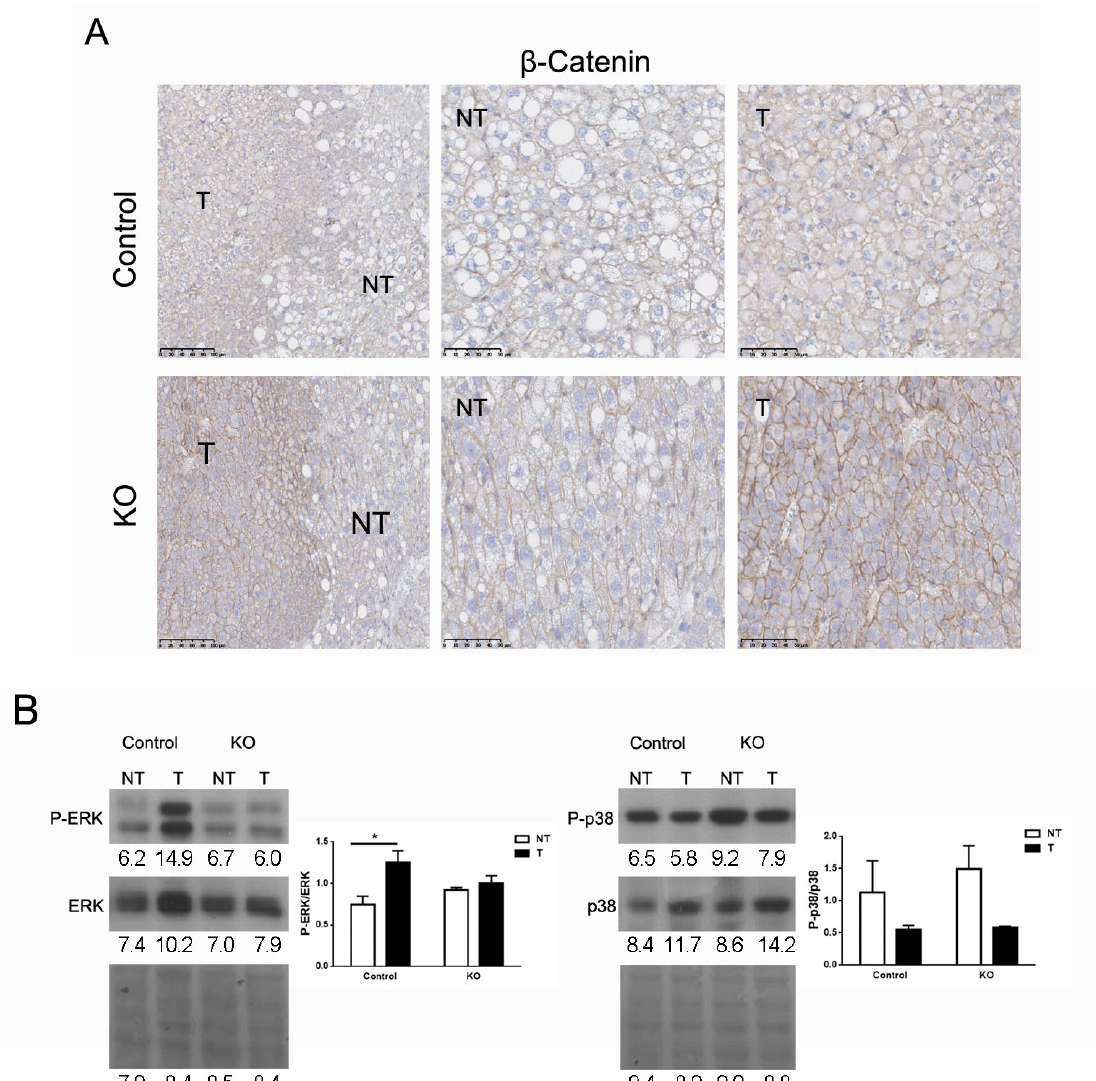
Figure 4. ARMCX3 deletion affects ERK signaling in hepatic tumors from HFD-fed mice. ( A ) Representative staining of β -catenin in liver sections from Control or ARMCX3-KO mice maintained on HFD. Sections include both non-tumor (NT) and tumor (T) regions and magnifications are shown. Scale bars: 100 µ m and 50 µ m (magnified). ( B ) Immunoblot analysis of the phosphorylation of ERK and p38 (representing pathway activation) in control and ARMCX3-KO mice exposed to HFD. Shown are representative immunoblot images (left) and quantification of phosphorylated/total ratios for ERK and p38 (right). Bars indicate means ± SEM; n = 2–4 mice per group. Two-Way ANOVA test with Tukey post hoc correction was used. * p ≤ 0.05 for comparisons between Control and KO samples.